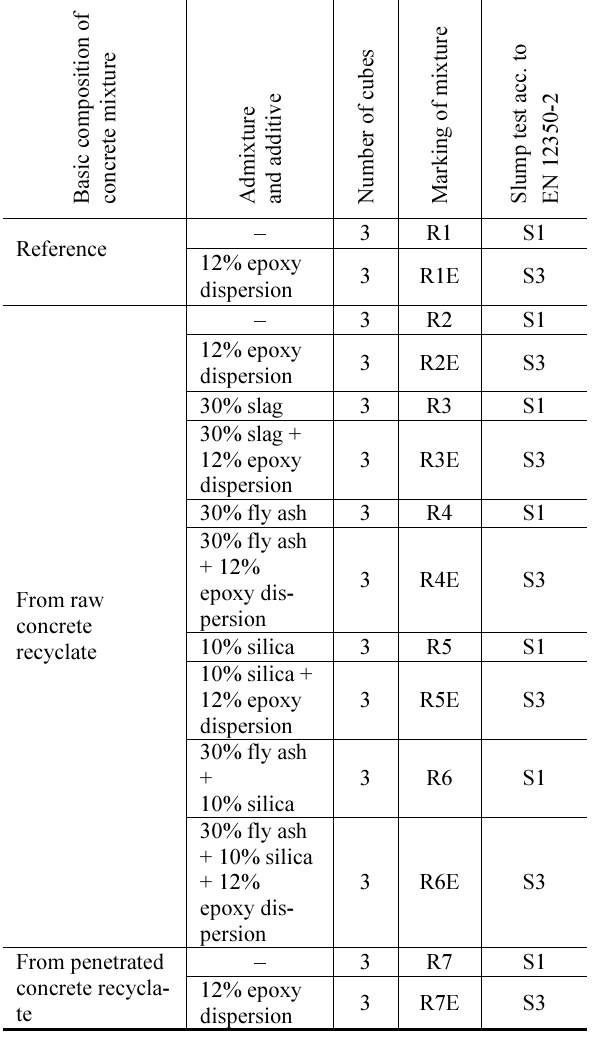
Table 1. Types and marking of concretes of seven sets of test